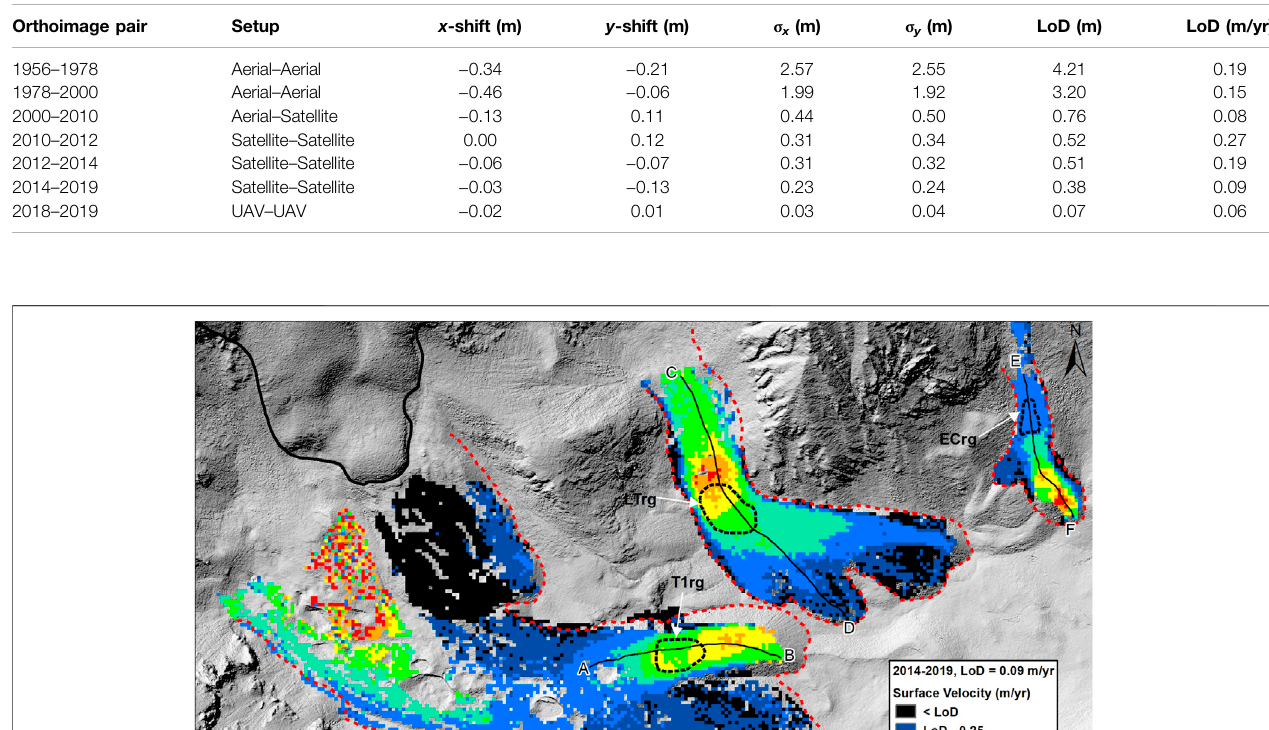
Frontiers in Remote Sensing |